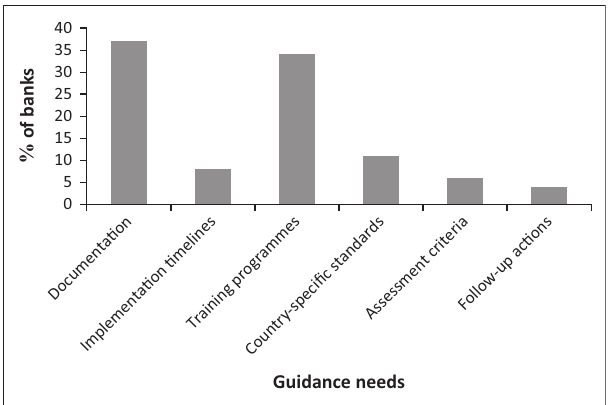
FIGURE 8: Guidance needs of participants.